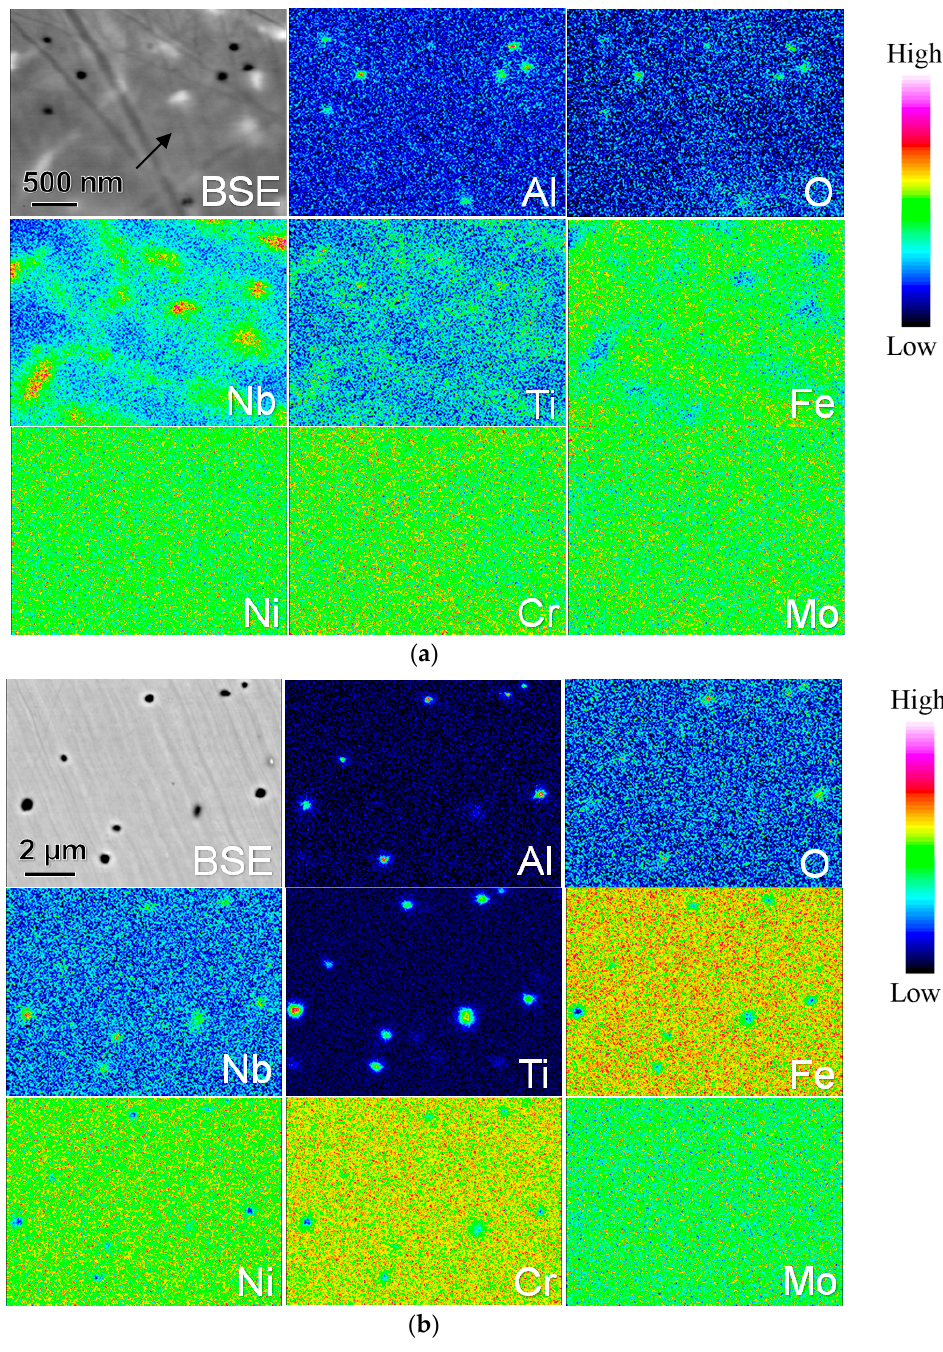
Figure 2. EPMA elemental mappings obtained from ( a ) SLM-fabricated and ( b ) EBM-fabricated IN718